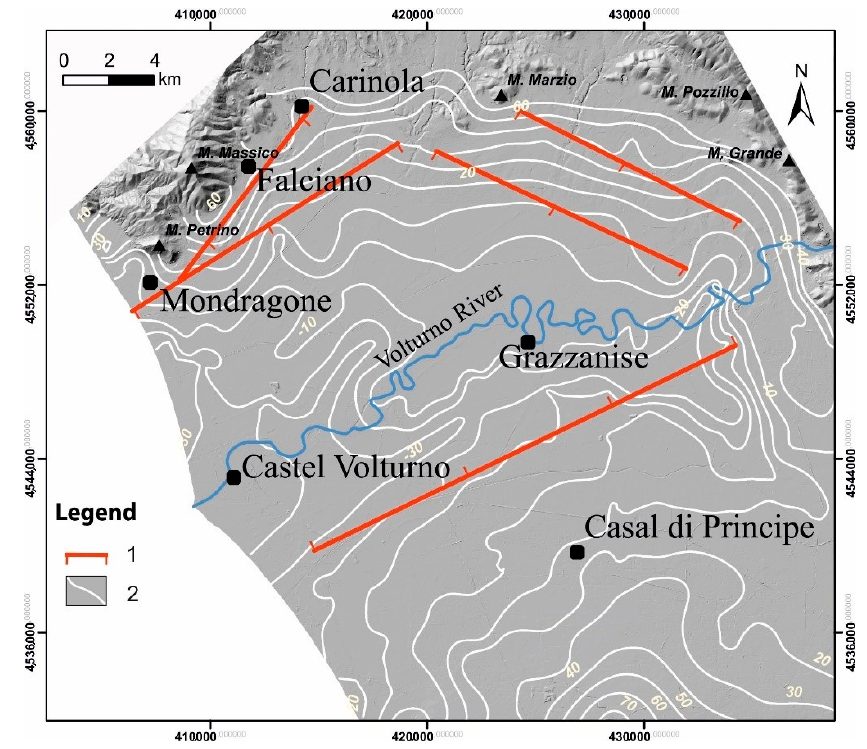
Figure 7. Map showing the CI unit upper morphological surface and the Quaternary main faults. Legend: (1) fault; (2) contour lines of the CI roof. In blue, the present Volturno River.